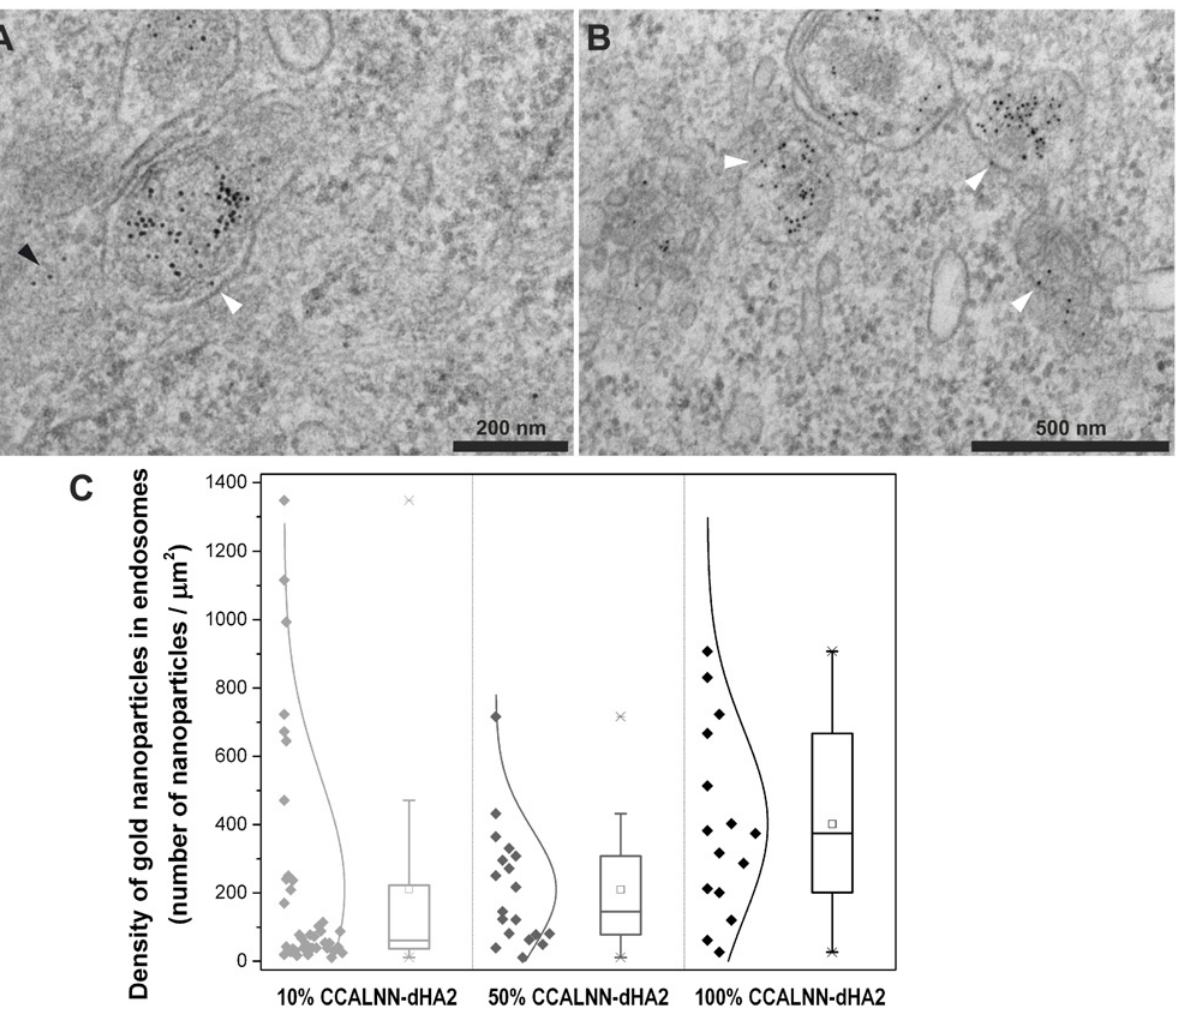
Fig 3. Influence of the proportion of CCALNN-dHA2 peptides in the monolayer of gold nanoparticles. HeLa cells were incubated for 4h with 10nm gold nanoparticles (6nM) coated with a monolayer composed of two different proportions of the peptides CCALNN-dHA2 and CALNN, washed thoroughly with PBS, fixed and imaged by electron microscopy. (A-B) TEM images of the cells incubated with nanoparticle with the following peptide monolayer composition: (A) 50% CCALNN-dHA2 and 50% CALNN, (B) 100% CCALNN-dHA2. Arrowheads point toward gold nanoparticles either interacting with vesicular membranes (white) or displaying a cytosolic localisation (black). (C) Density of nanoparticles in endosomes estimated from images shown in (A) (n = 10, middle) and (B) (n = 10, right); quantification for 10% CCALNN-dHA2 (left) is the same as in Fig. 2E (left). The sets of images analysed are available on figshare (10.6084/m9.figshare.875545,